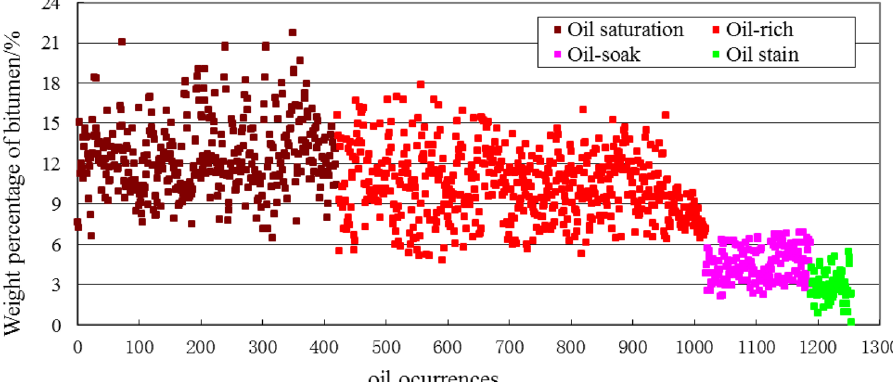
Fig. 4 Distribution of weight percentage of bitumen with dif- ferent oil